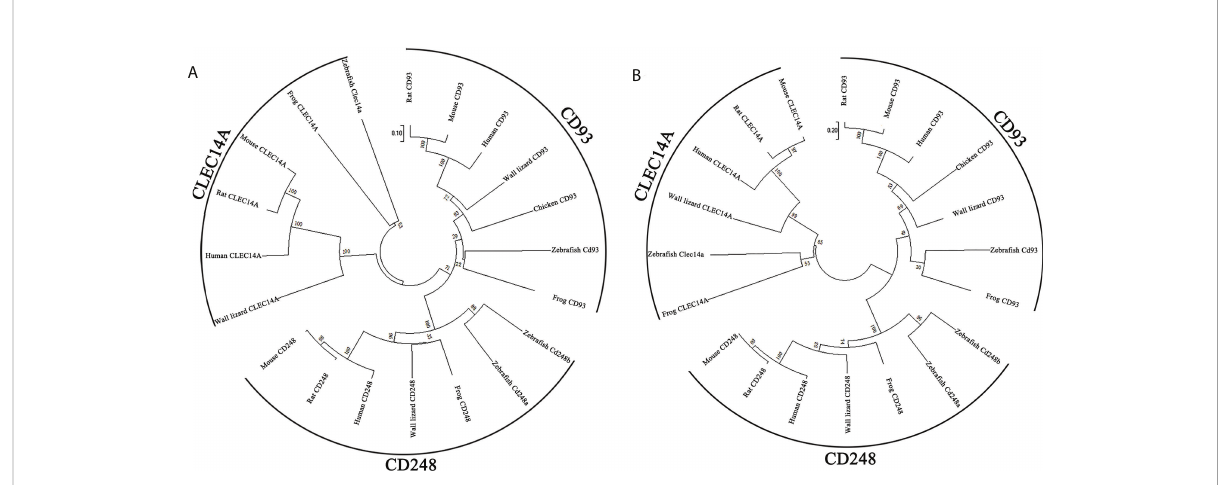
FIGURE 3 Phylogenetic trees of Cd248a and Cd248b. Phylogenetic trees constructed from the amino acid sequences of homologous genes of various species. CD248, CD93 and CLEC14A are members of the C-type lectin group 14 family. (A) neighbor-joining method; (B) maximum-likelihood method. The reliability of each node was estimated by bootstrapping with 1000 replications. The numbers shown at each node indicate the bootstrap values